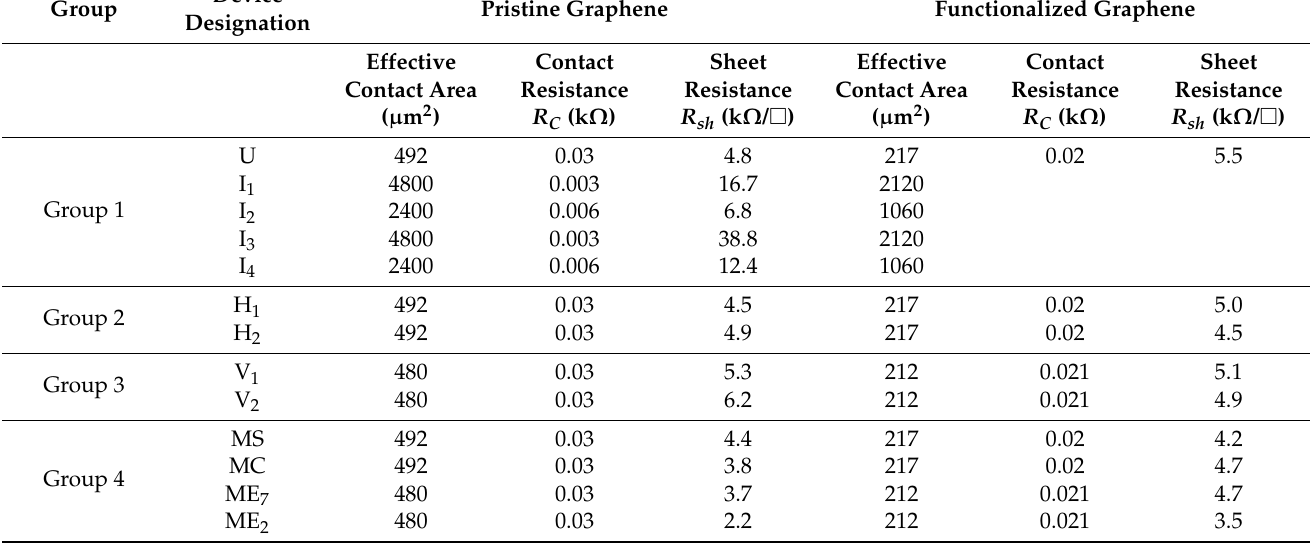
graphene are shown in Table